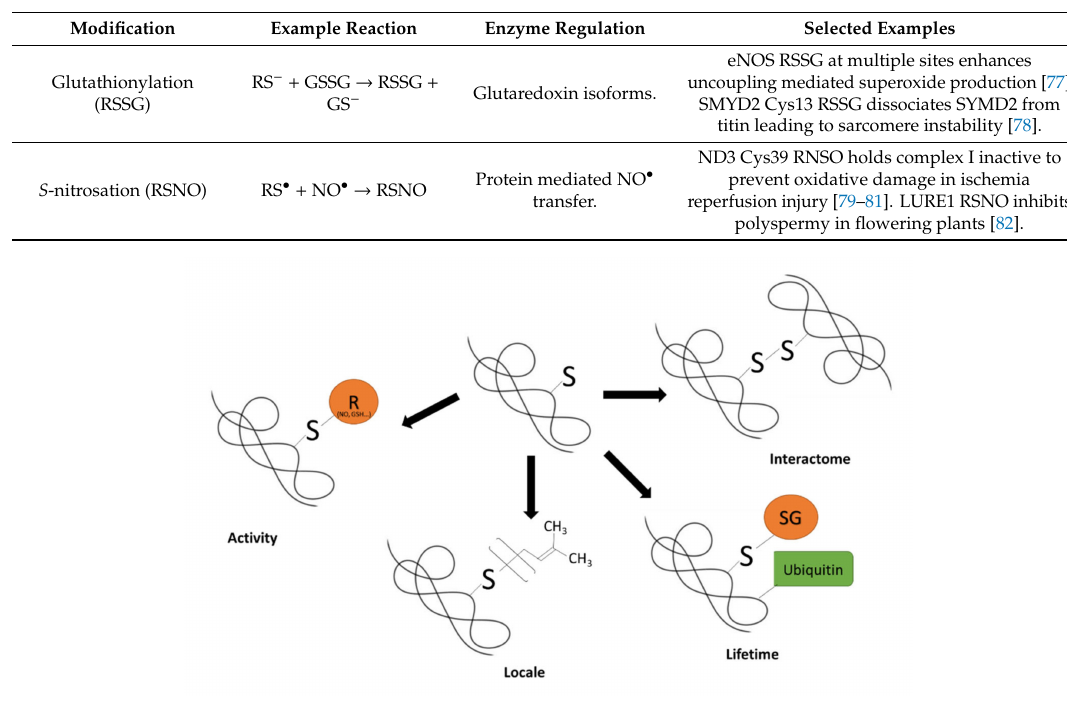
Figure 1. Functional aspects of reversible thiol oxidation. The schematic depicts the four main impacts of reversible thiol oxidation on protein function: activity, locale, interactome, and lifetime. For illustrative purposes, S -prenylation is depicted and an RSSG modification leading to ubiquitination. In principle, any modification could exert an e ff ect by any of the major functional aspects described (e.g., interactome e ff ects are not restricted to